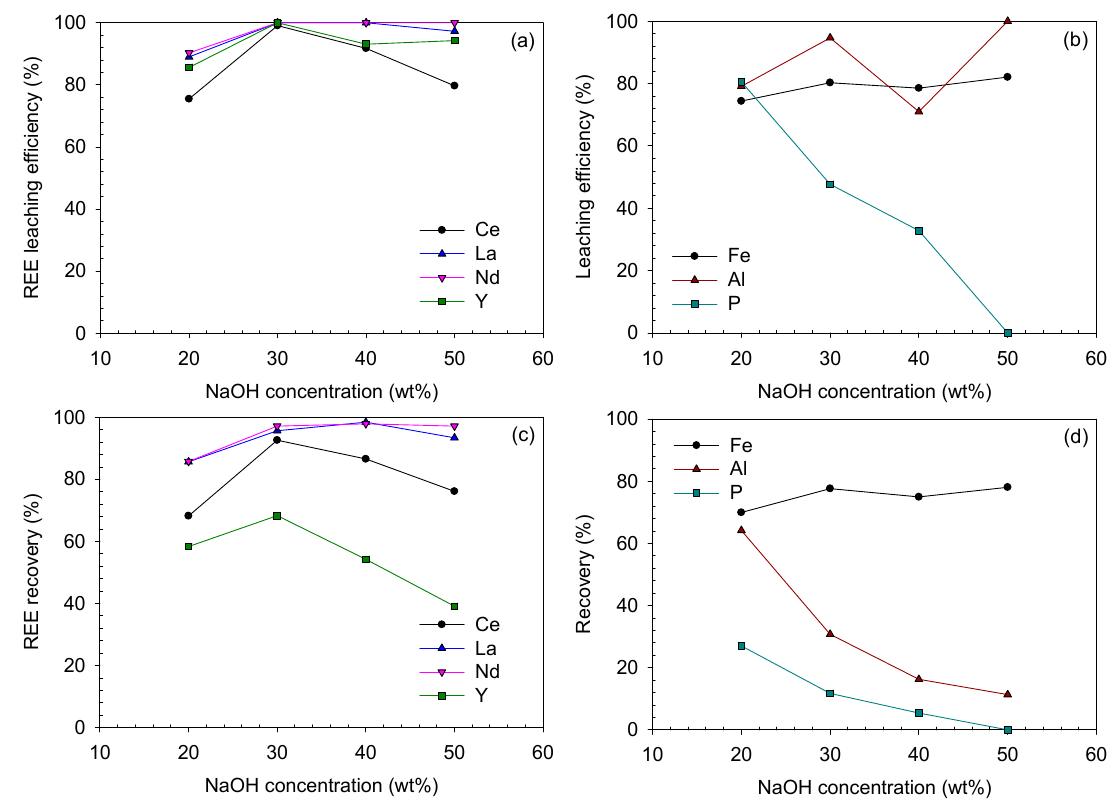
Figure 16. Leaching e ffi ciencies and recoveries after acid-leaching of the caustic digested ore at digesting NaOH concentrations of 20–50 wt% (leached using 3.0 M HCl at 80 ◦ C for 3 h): ( a ) REE and ( b ) Fe-, Al- and P-leaching e ffi ciencies (%); ( c ) REE and ( d ) Fe, Al and P recoveries (%) .